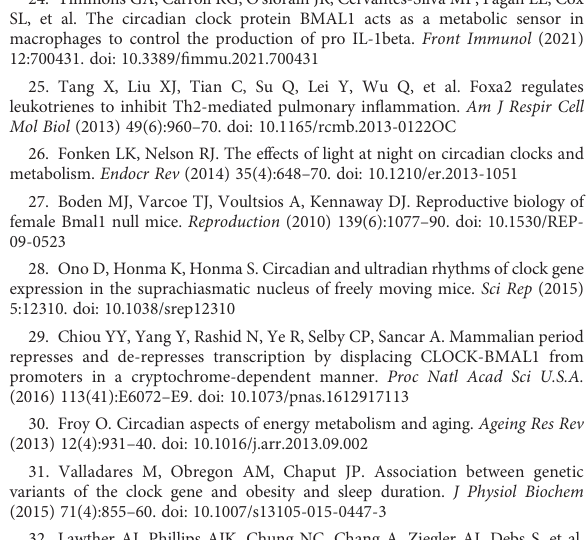
SUPPLEMENTARY TABLE 4 Pearson ’ s correlation coef fi cient for the concentrations of circadian clock